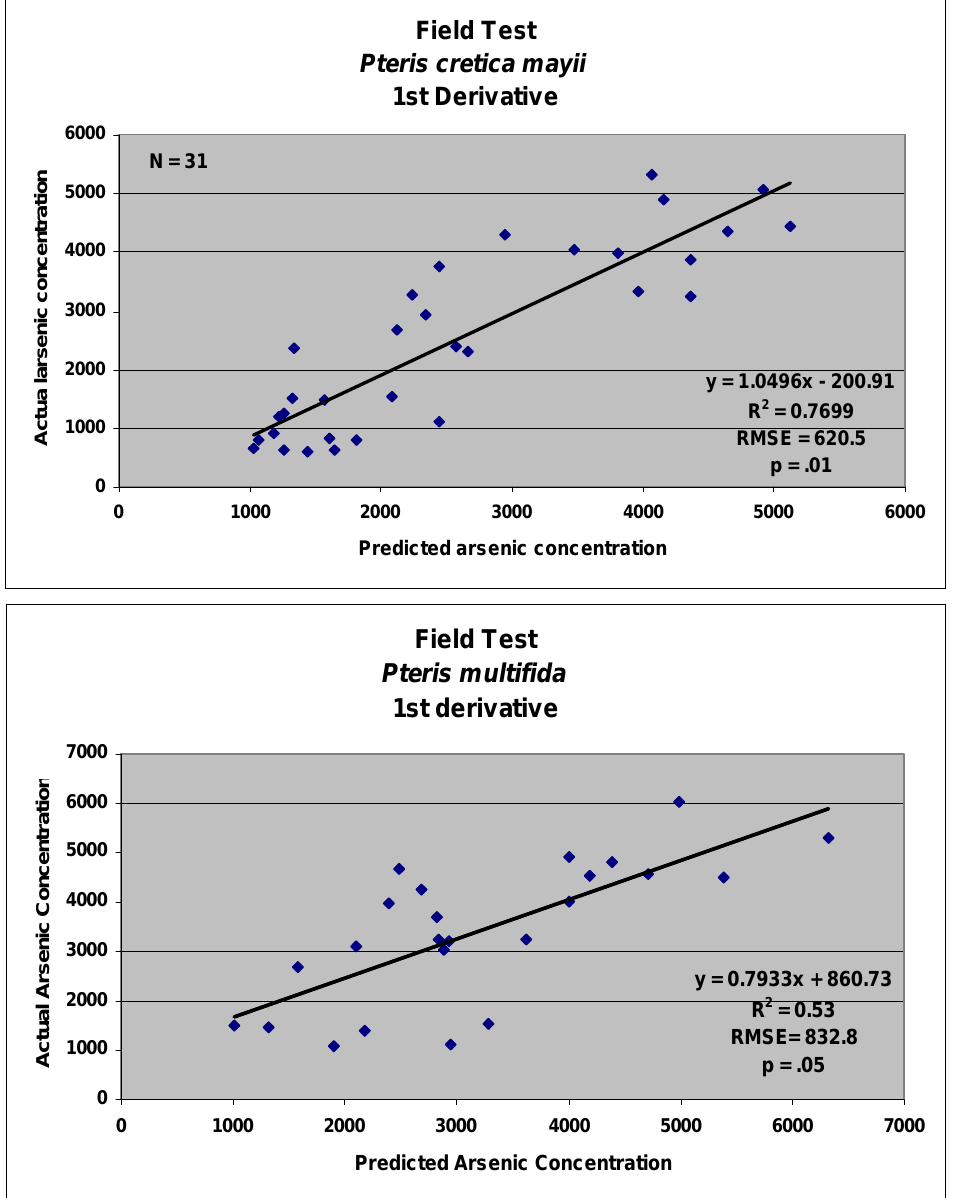
Figure 12. Results of testing the arsenic prediction models on field